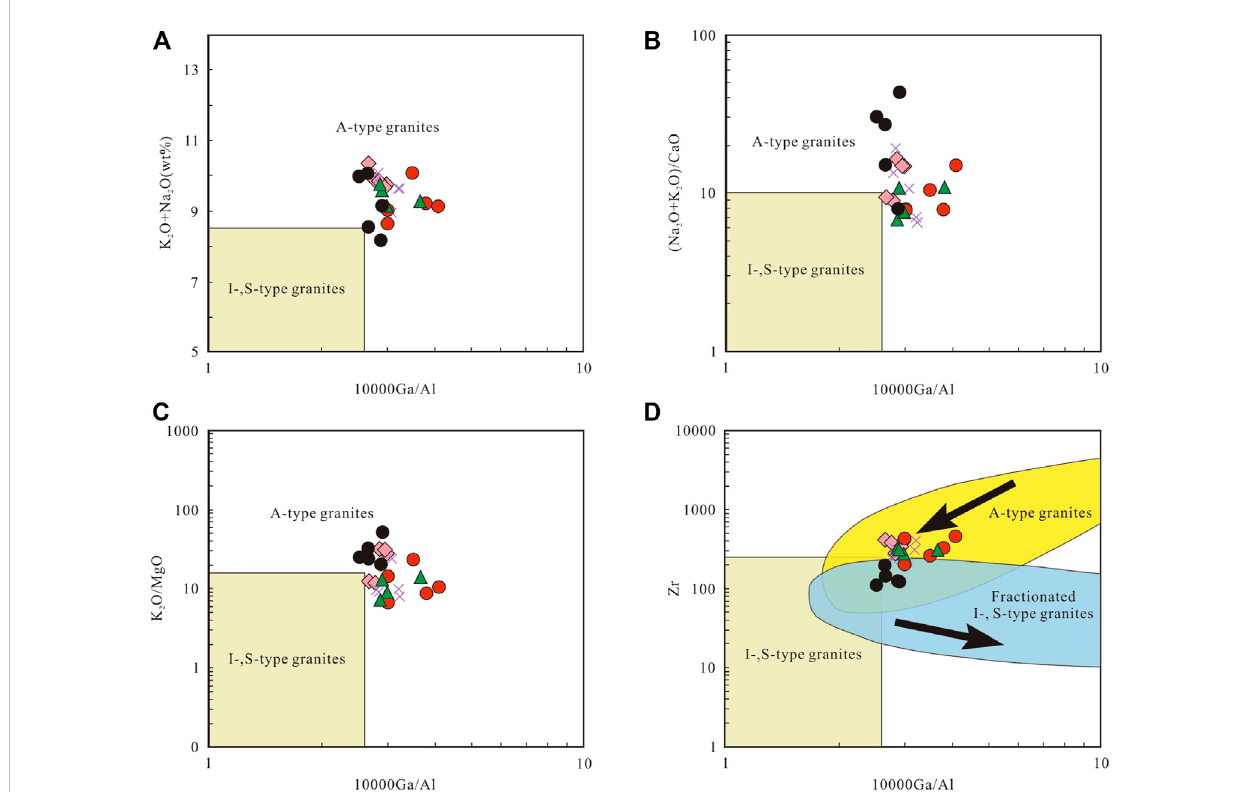
FIGURE 7 10000Ga/Al versus K 2 O + Na 2 O (A) , (N 2 O + ka 2 O)/CaO (B) , K 2 O/MgO (C) , and TFeO/MgO (D) diagram (adapted from Whalen et al., 1987; Wu et al., 2017) for the granite in Chuhuertu. Symbols are the same as in Figure